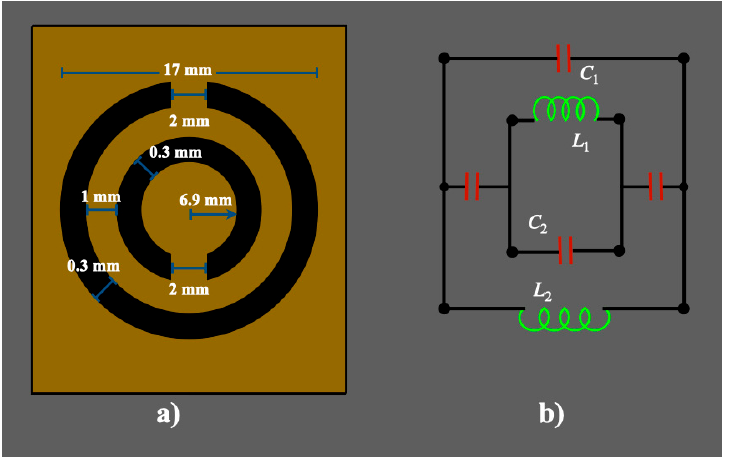
Figure 1. Schematic representations of the split ring resonator (SRR) showing dimensions ( a ) and its equivalent circuit ( b ).